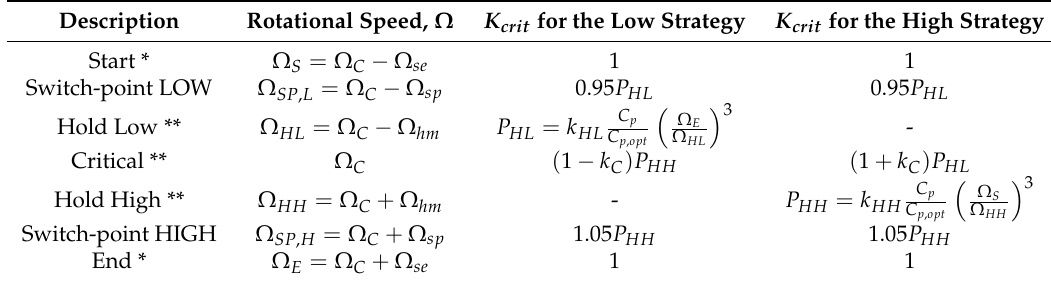
Table 1. The LUT key points. The equations for hold low and hold high are derived in Appendix A.